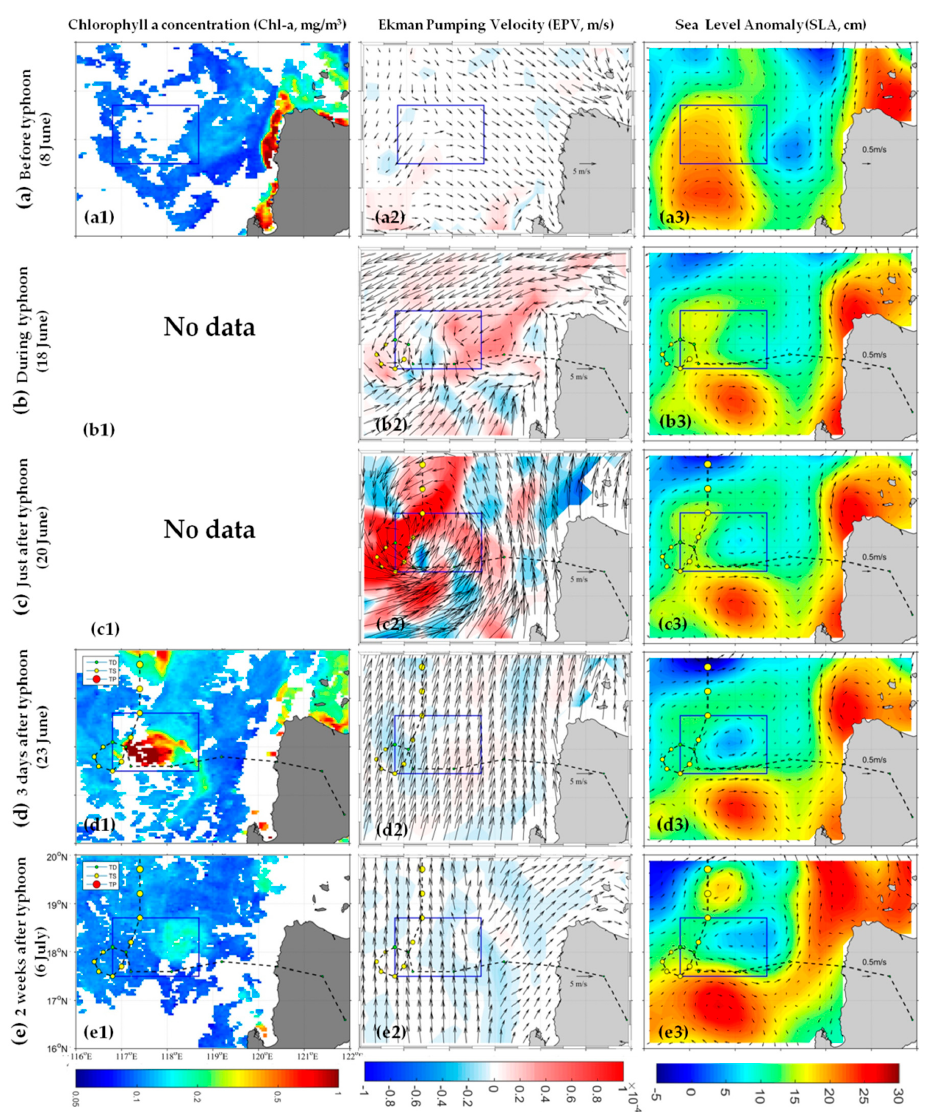
Figure 5. Daily distribution map of the Chl-a (mg/m 3 ), EPV (m/s), and SLA with geo-SSCs before and after the typhoon (( a ) 10 days before typhoon; ( b ) during typhoon; ( c ) just after typhoon; ( d ) 3 days after typhoon; ( e ) 2 weeks after the typhoon; the blue box indicates the study area, the black dotted line indicates the typhoon path, and the arrows in the second column indicate the wind vectors, the arrows in the third column indicate the geo-SSCs).